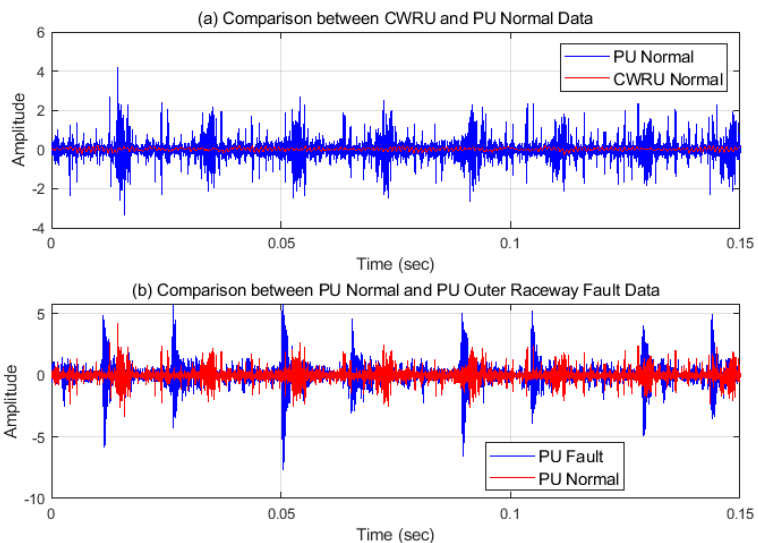
Figure 8. ( a ) Normal signal of CWRU and PU data. ( b ) Normal and outer-raceway fault signal of PU data.